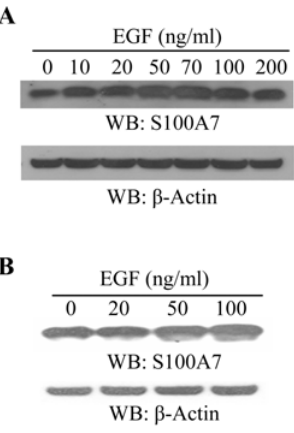
Figure 1. EGF stimulation enhances S100A7 expression in breast cancer cells. 70–80% confluent MCF-7 cells (A) and MDA-MB- 468 cells (B) were washed twice and rinsed with PBS followed by 18 hrs of serum starvation. The cells were then stimulated with various concentrations of epidermal growth factor (EGF) for 30 minutes at 37 u C. The cells were lysed and S100A7 expression was analyzed by Western blotting with anti-S100A7 antibody, as indicated. Equal protein loading in each lane was checked by stripping the blots and probing with b - Actin antibody (A and B, lower panels). The experiments were repeated thrice with identical